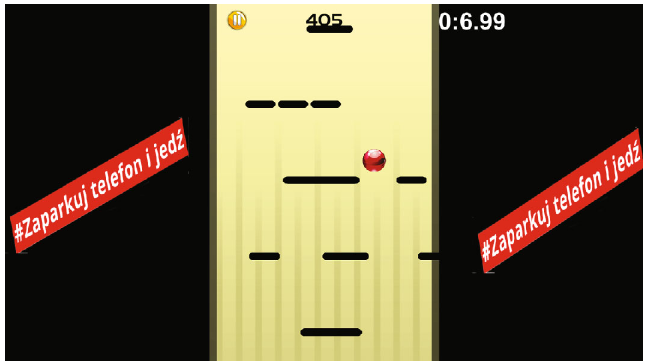
Figure 10: Screenshot showing a computer game of ball control with advertisement #Zaparkuj telefon i jed ź ( “ #Park the phone and go ” ).